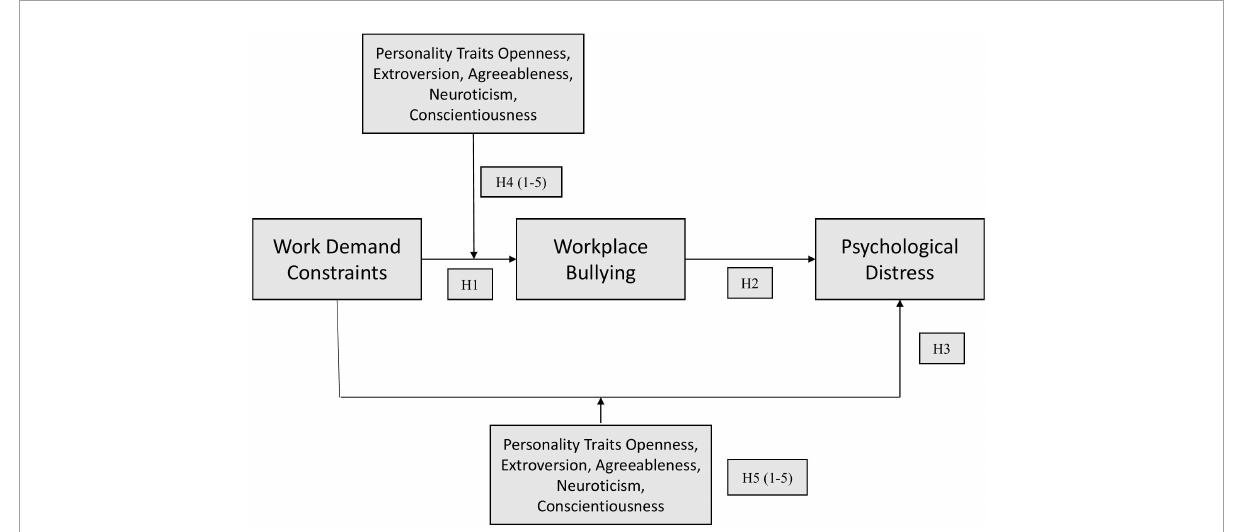
FIGURE1 Theoretical framework.